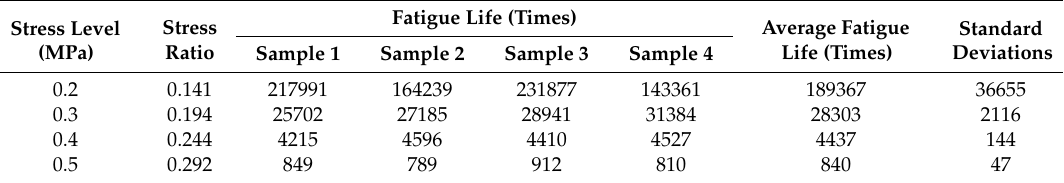
Table 9. The rubber asphalt mixture fatigue test